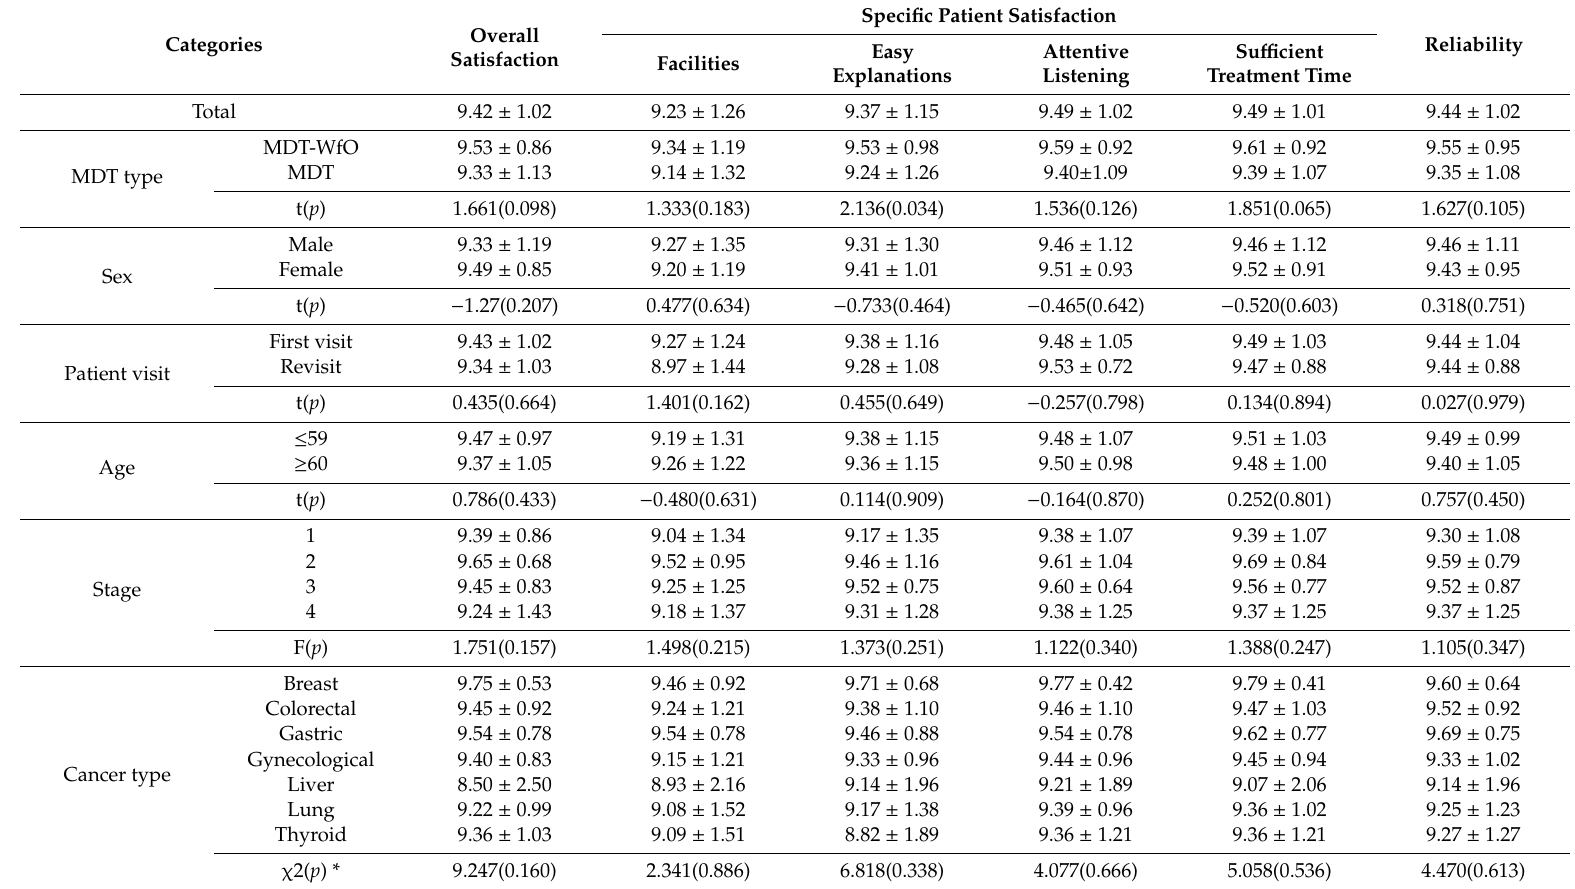
Table 3. Patient satisfaction and